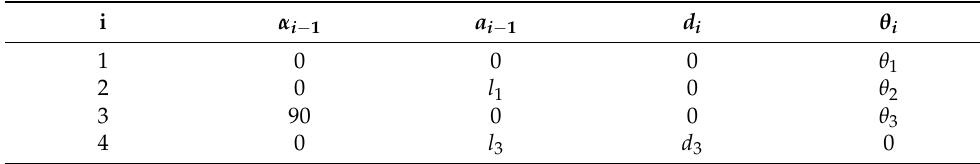
Table 1. DH parameters of the new above-knee